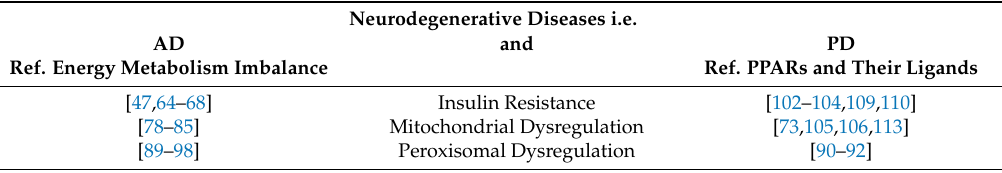
Table 1. Table summarizing the references on energy metabolism imbalance in neurodegenerative disorders and on PPARs and PPAR